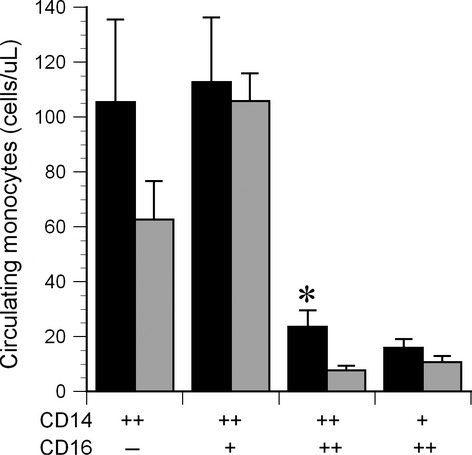
Circulating monocyte counts (n = 34). Black bars represent men, gray bars represent women. *The CD14++16++ monocyte count was significantly higher in men than women, P = 0.001.